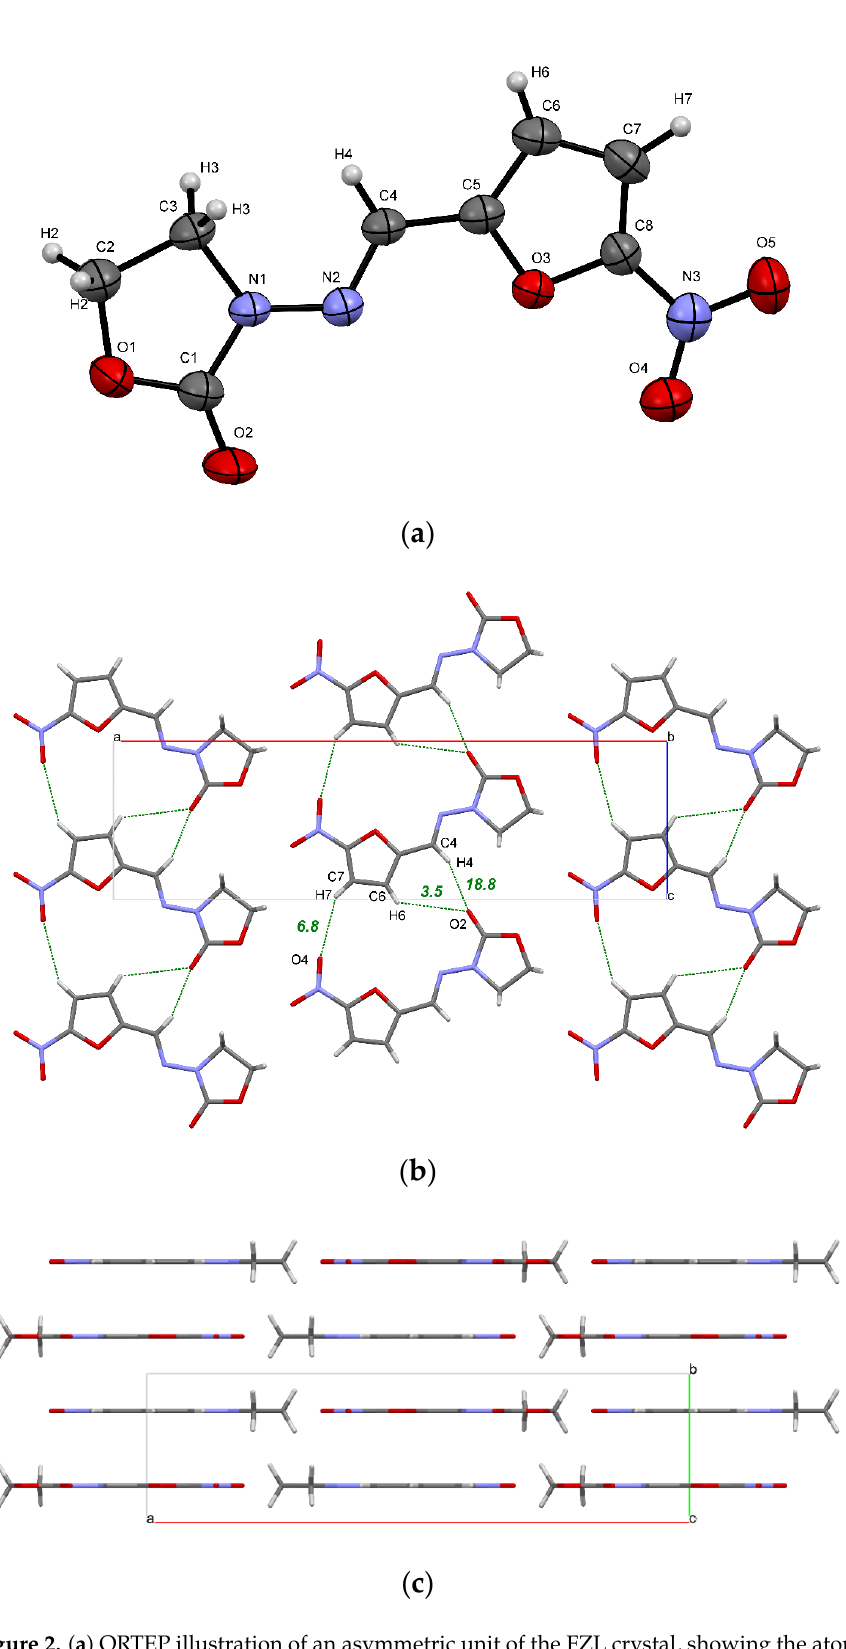
Figure 2. ( a ) ORTEP illustration of an asymmetric unit of the FZL crystal, showing the atom-labelling scheme. Thermal ellipsoids are drawn at the 50% probability level; ( b ) a 2D layer of FZL molecules formed by C−H···O bonds (green dots) and weak interactions ; ( c ) packing of 2D layers in the crystal. The numbers indicate the energy of H-bonds estimated using Equation (11) in kJ·mol −1 .